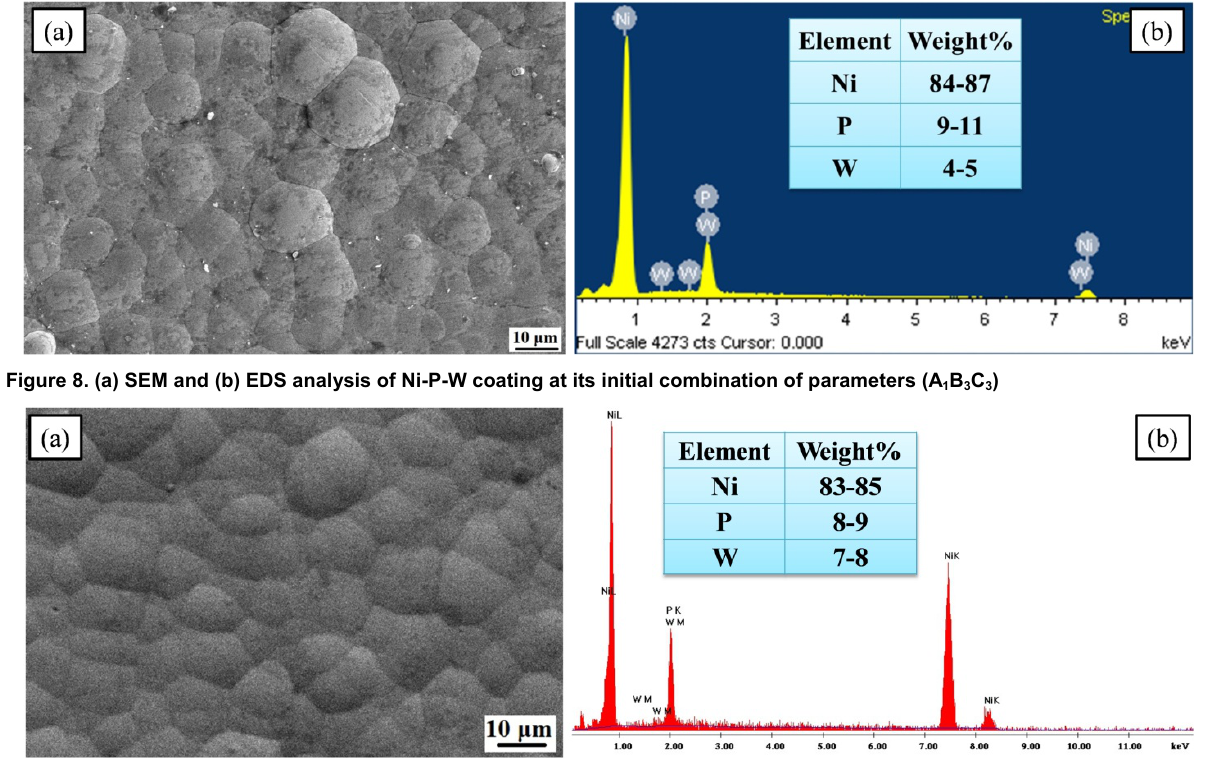
Figure 9. (a) SEM and (b) EDS analysis of Ni-P-W coating at its optimal combination of parameters (A 3 B 2 C 2 )